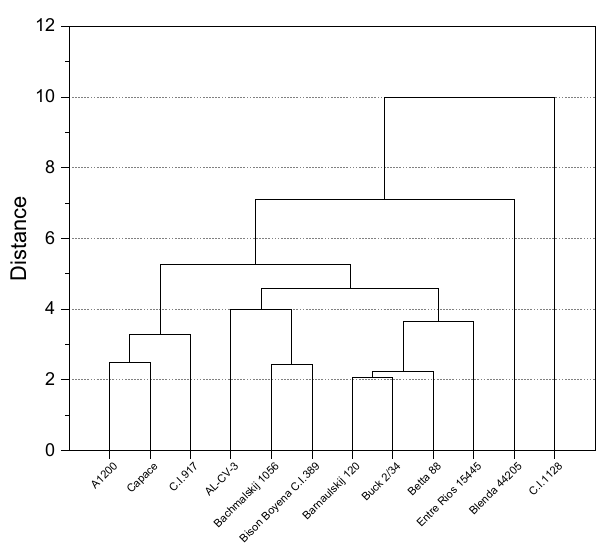
Fig. 8 Dendrogram derived from a cluster analysis of 12 flax accessions from across the world (Group